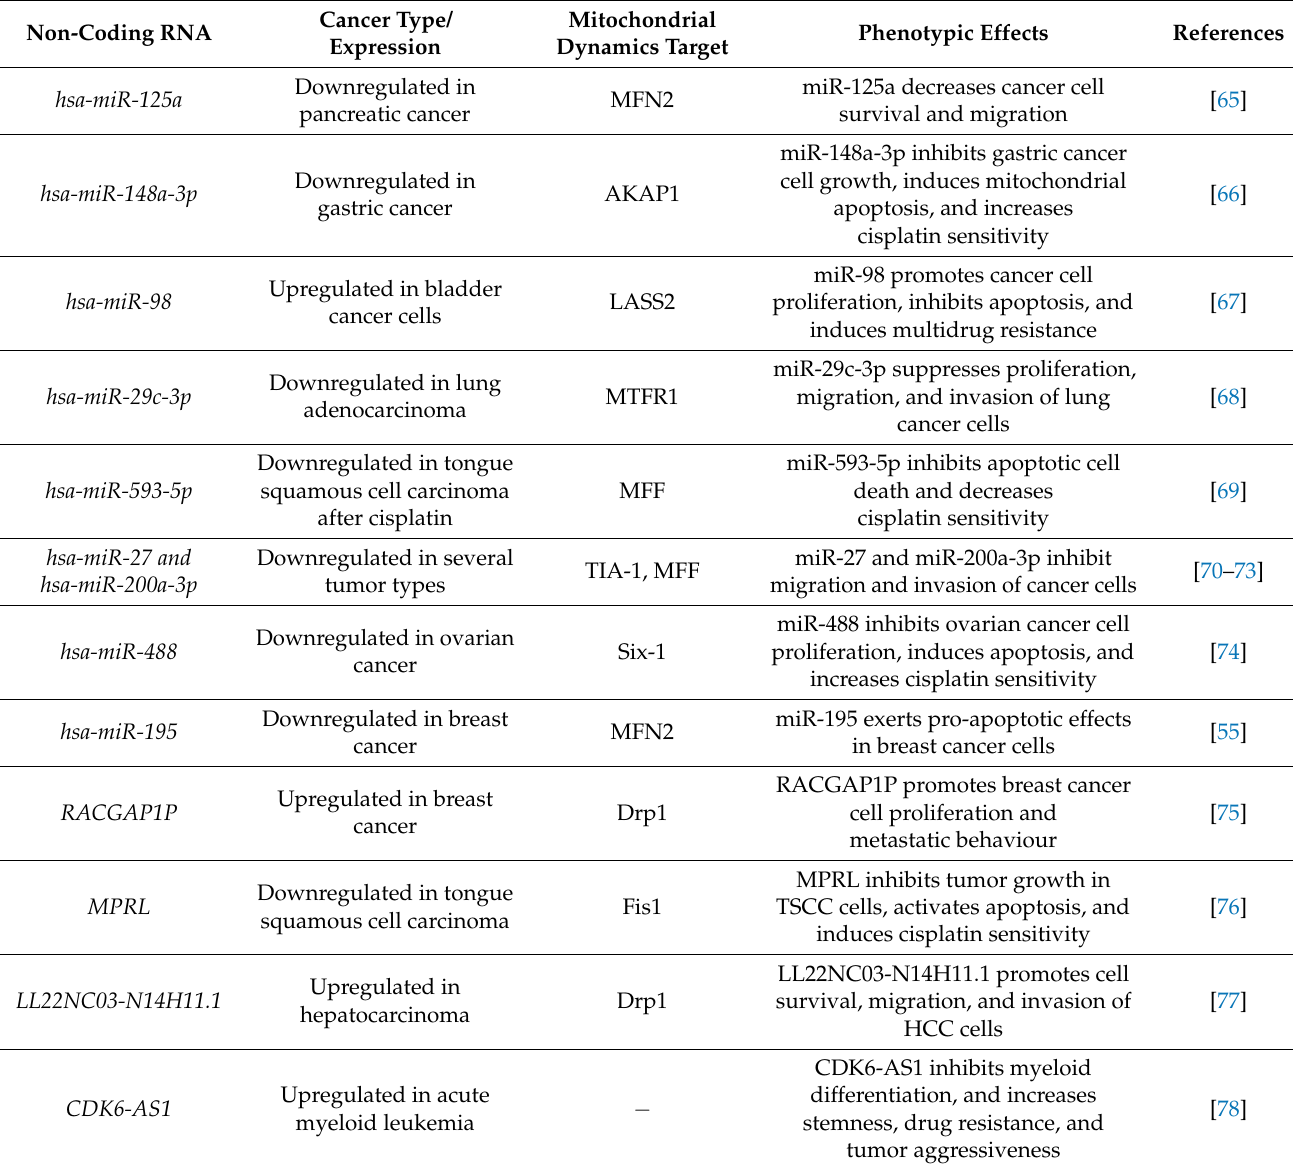
Table 1. Cancer-associated ncRNAs targeting mitochondrial dynamics